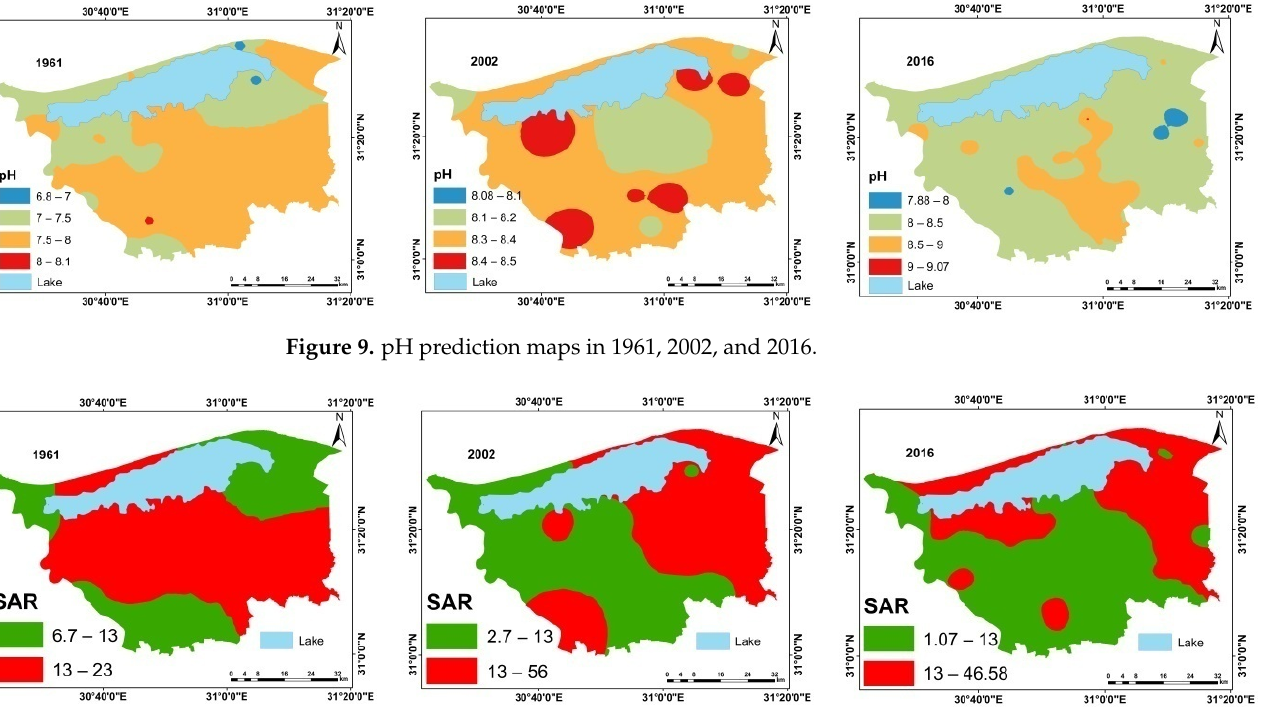
Figure 10. Prediction SAR maps in 1961, 2002, and 2016.